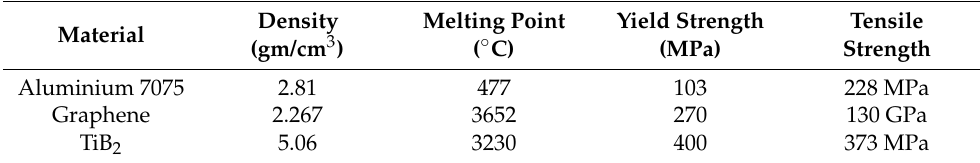
Table 1. Mechanical properties of matrix and reinforcing materials.